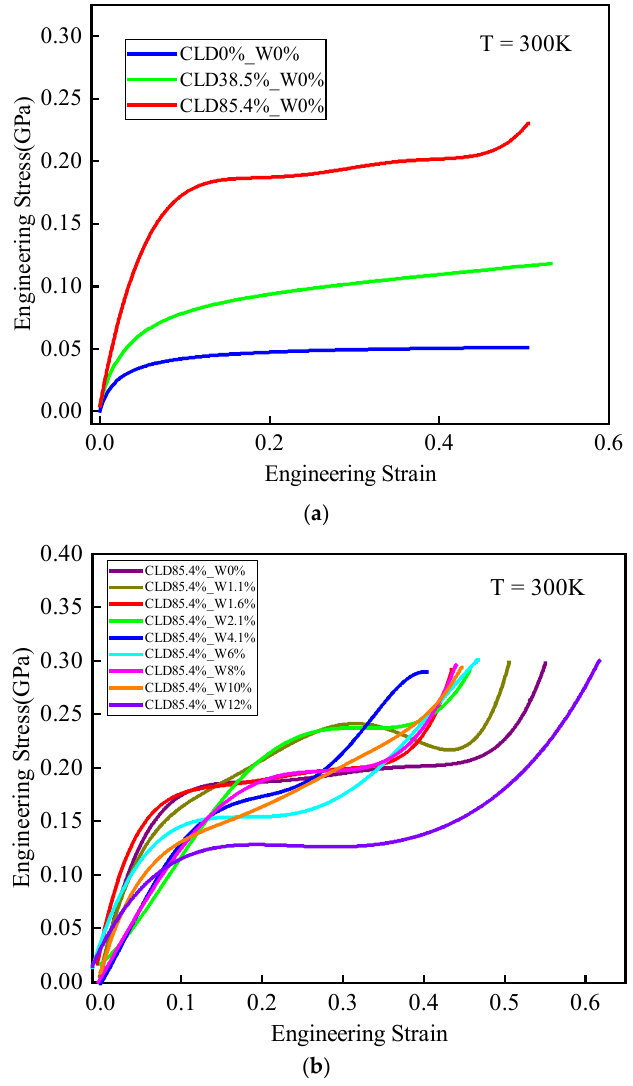
Figure 14. Stress-strain curves for ( a ) various degrees of cross-linking and ( b ) various moisture concentrations. CLD0%_W0% means a system with degree of cross-linking of 0% and moisture concentration of 0 wt.%.